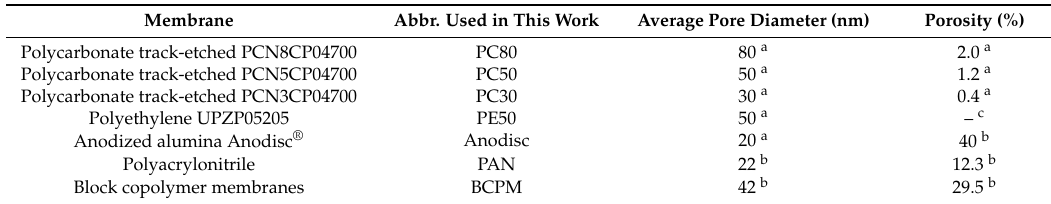
Table 1. Membranes and geometrical features used in this